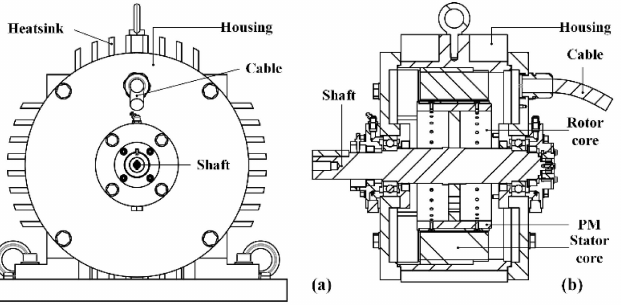
Figure 11. Schematic of the prototype combined with the housing and shaft: ( a ) cross-sectional view; ( b ) side view.